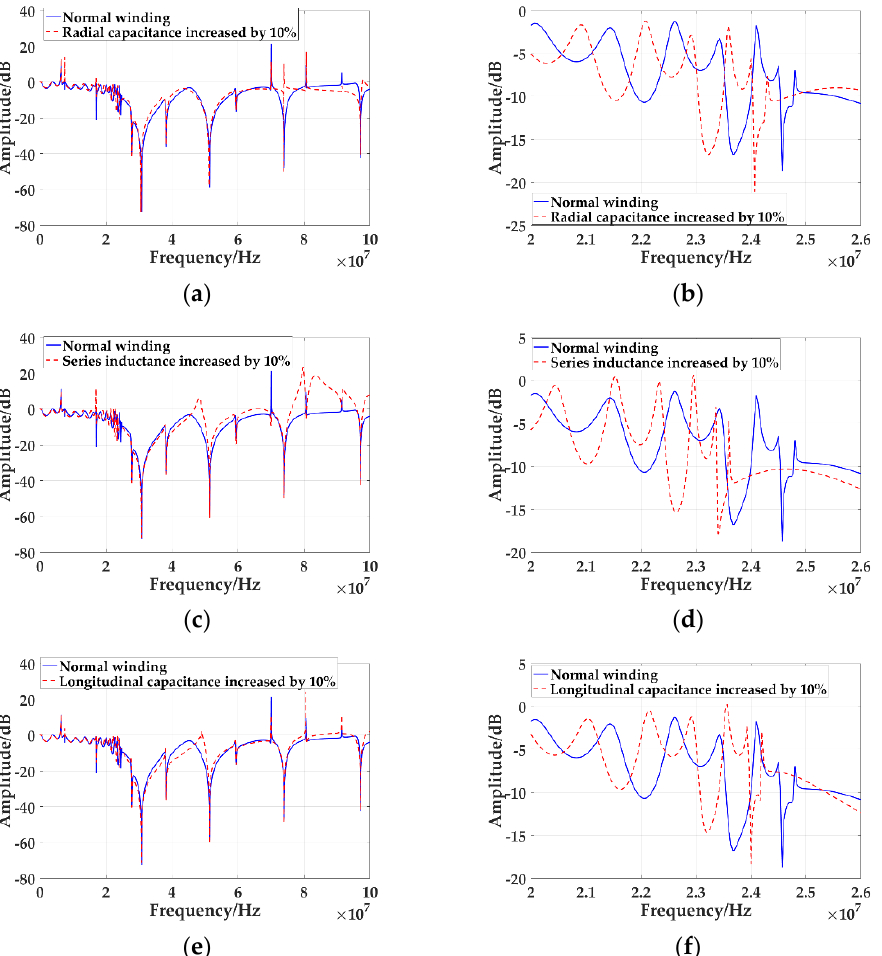
Figure 10. Simulation results of three types of winding faults: ( a ) Frequency response curve of overall winding axis offset; ( b ) Frequency response curves of winding radial deformation from 20 MHz to 26 MHz; ( c ) Frequency response curve of the whole winding radial deformation; ( d ) Frequency response curve of radial winding deformation 20 MHz to 26 MHz; ( e ) The overall frequency response curve of winding inter-cake spacing variation; ( f ) Frequency response curve of winding inter-cake spacing variation 20 MHz to 26